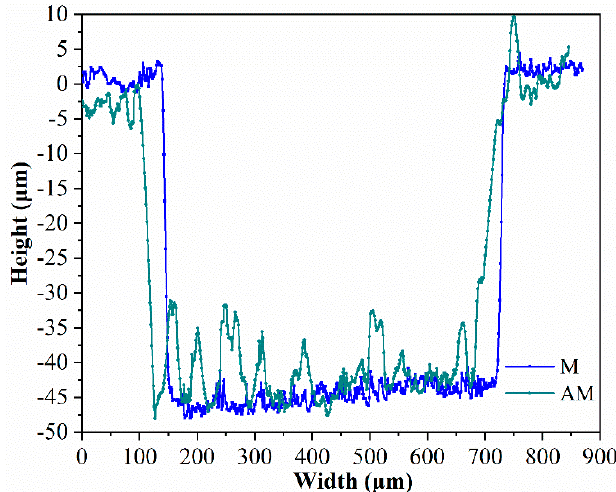
Figure 5. Cross-sectional view of a single micro-texture before and after anodizing.